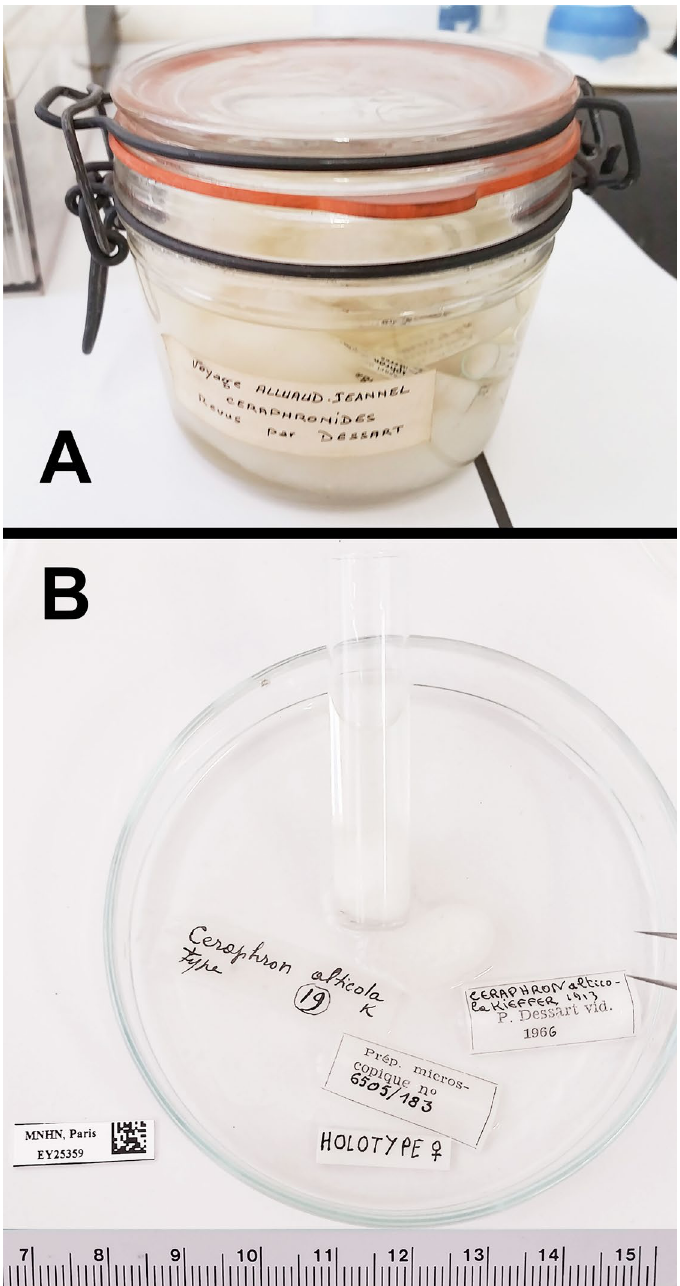
Fig. 1. A . An image of the glass bail-lid jar containing several kieffer type specimens collected by Ch. Alluaud and r. Jeannel during an expedition to Africa from 1911 to 1912. The specimens are stored in ethanol, in separate glass vials inside the jar. B . An image of the ethanol vial and labels for Ceraphron alticola kieffer, 1913 (MNhN